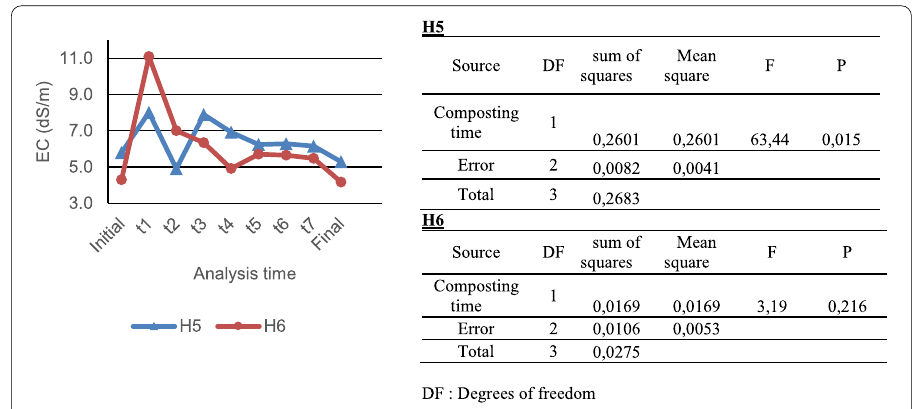
Fig. 10 EC evolution during co‑composting of TM and OP (left) and ANOVA test associated (right)